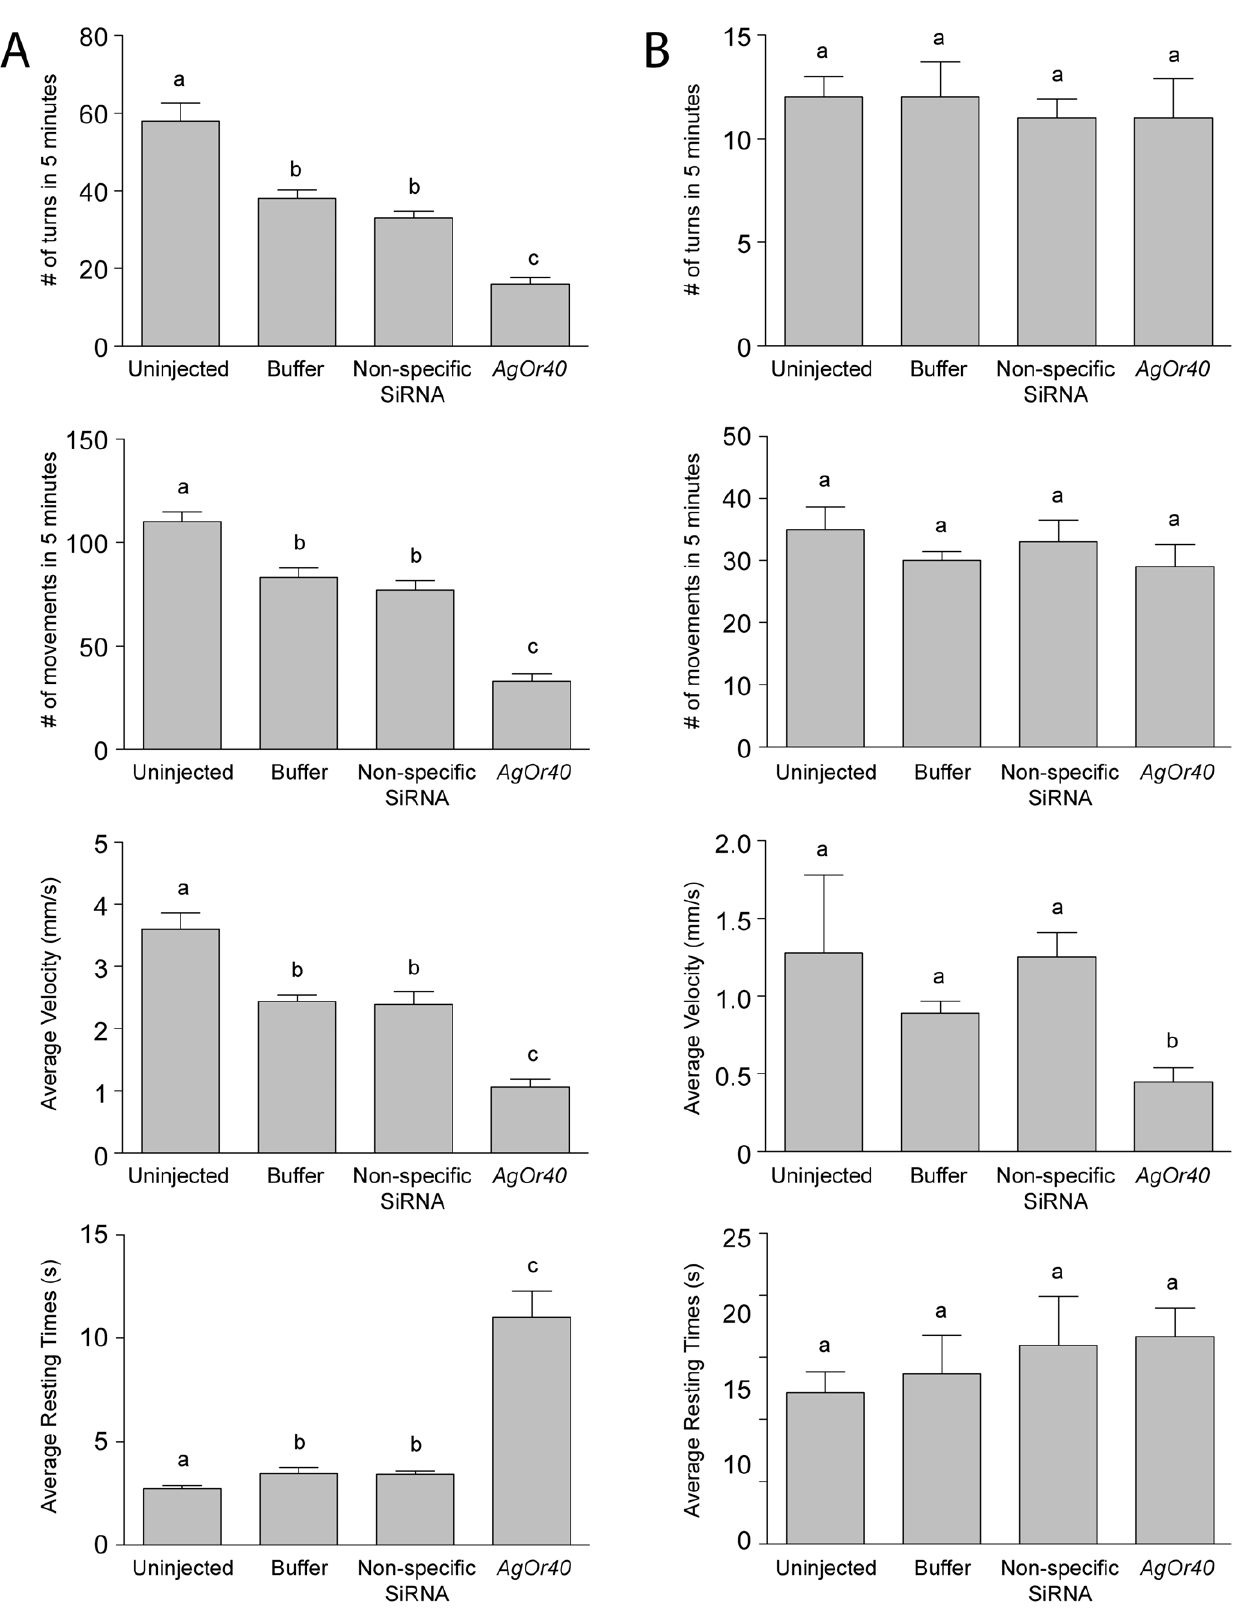
Figure 7. Differential sensitivity of larval responses in An.gambiae to siRNA-mediated knockdown of AgOr40 is odorant dependent. Larval responses exhibited by uninjected larvae as well as those receiving mock (buffer-alone), non-specific, or siRNA injections in response to DEET (A) and yeast paste (B) were assessed independently over a 5 min time lapse. Larval responses to 1.6 mg/ml yeast paste were unaffected by any